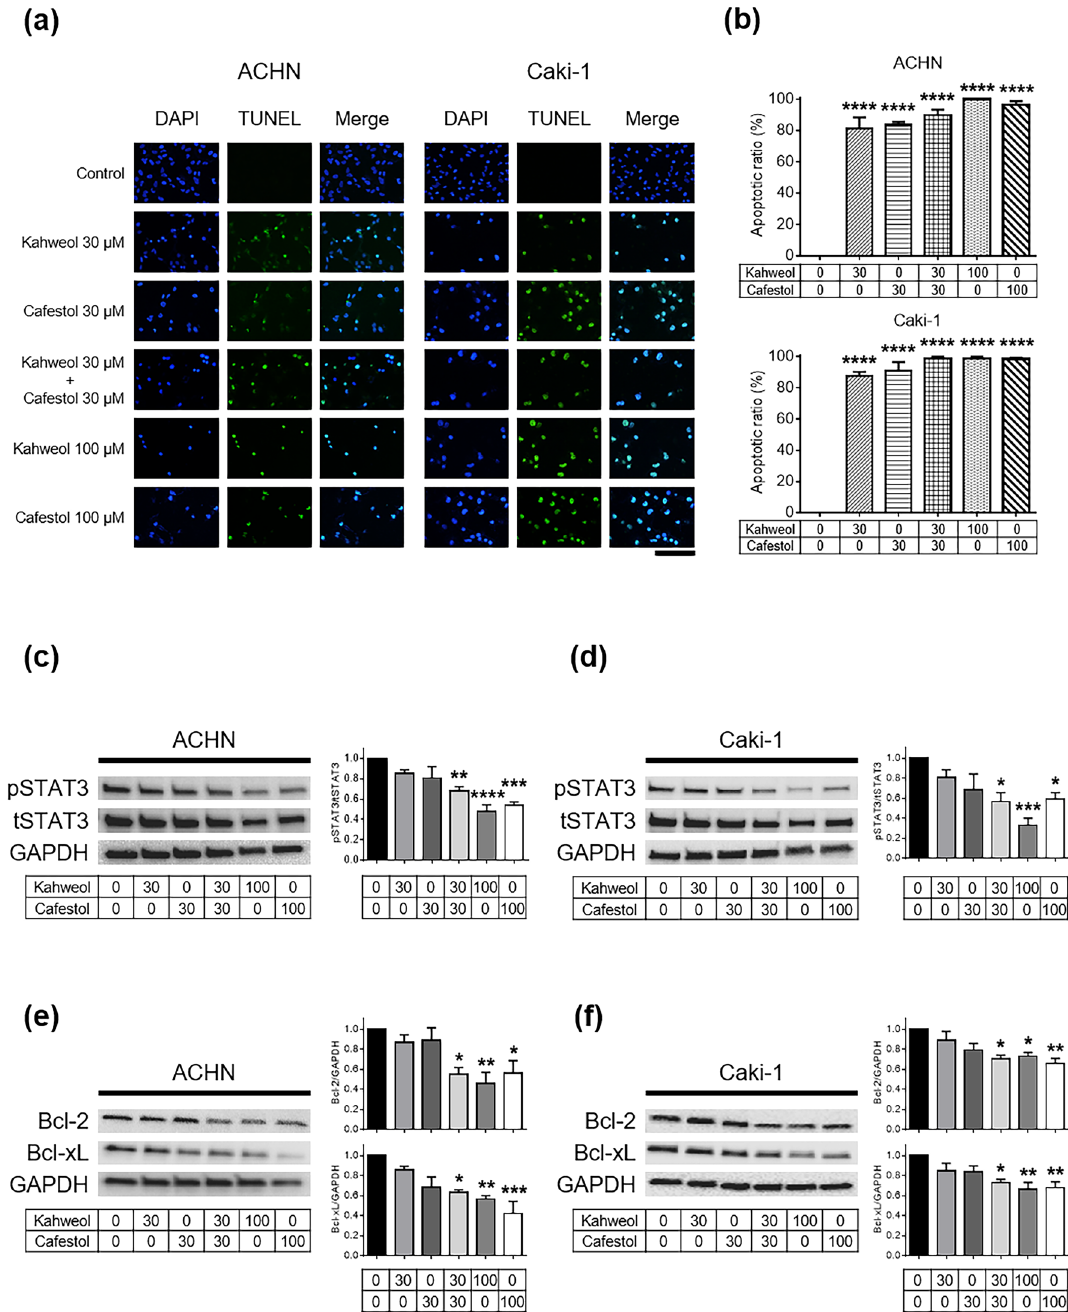
Figure 2. Kahweol acetate and cafestol treatment induced apoptosis by downregulating anti-apoptotic proteins in renal cancer cells. ( a , b ) TdT-mediated dUTP-biotin nick end labeling (TUNEL) assay ( a ) and statistics ( b ) showing apoptosis of ACHN or Caki-1 cells under kahweol acetate and cafestol treatment. ACHN and Caki-1 cells (3 × 10 4 cells) were exposed to predetermined concentrations of kahweol acetate and cafestol for 12 h on sterile slide coverslips, after which TUNEL assays were performed. All experiments were performed in triplicate. Data are presented as means ± standard error of the mean (SEM). Bar = 50 µm. ( c – f ) Protein levels of apoptosis- associated genes, p/tSTAT3 in ACHN ( c ) and Caki-1 ( d ) cells, Bcl-2/Bcl-xL in ACHN ( e ) and Caki-1 ( f ) cells, treated for 24 h were measured using Western blot analysis and quantitatively analyzed using densitometry with ImageJ software as shown by bar graphs. Equal amounts of cell lysates (10 µg) were subjected to electrophoresis. Data are presented means ± SEM (n = 4). * p < 0.05; ** p < 0.01; *** p < 0.001; **** p <